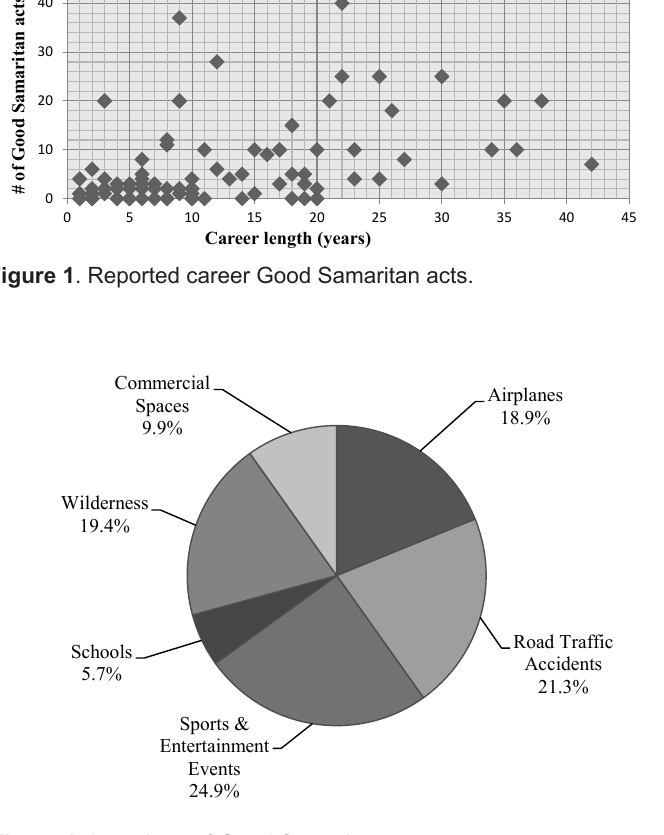
Figure 2 . Locations of Good Samaritan events.